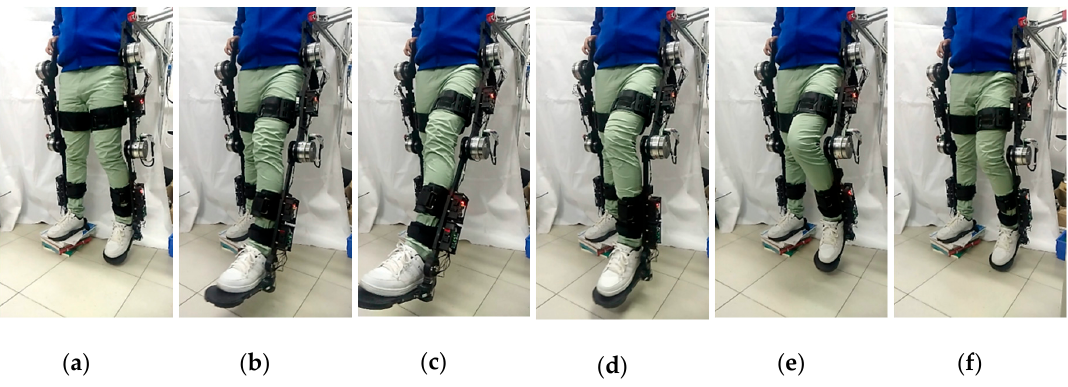
Figure 8. The experimental procedure. ( a ) Vertical state. ( b ) Hip-joint starts to flex. ( c ) Hip-joint rotates to 35 degrees. ( d ) Knee joint starts to extend. ( e ) Knee joint rotates to 60 degrees. ( f ) Exoskeleton restores to vertical